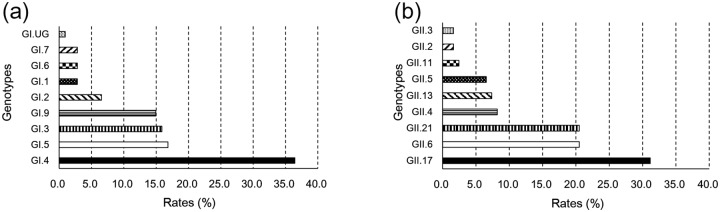
Prevalence of human norovirus (HNoV) genotypes in water samples.Relative prevalence of genotypes of GI sequences (a) and all GII sequences (b). Each pattern of horizontal bars indicates a distinct genotype.